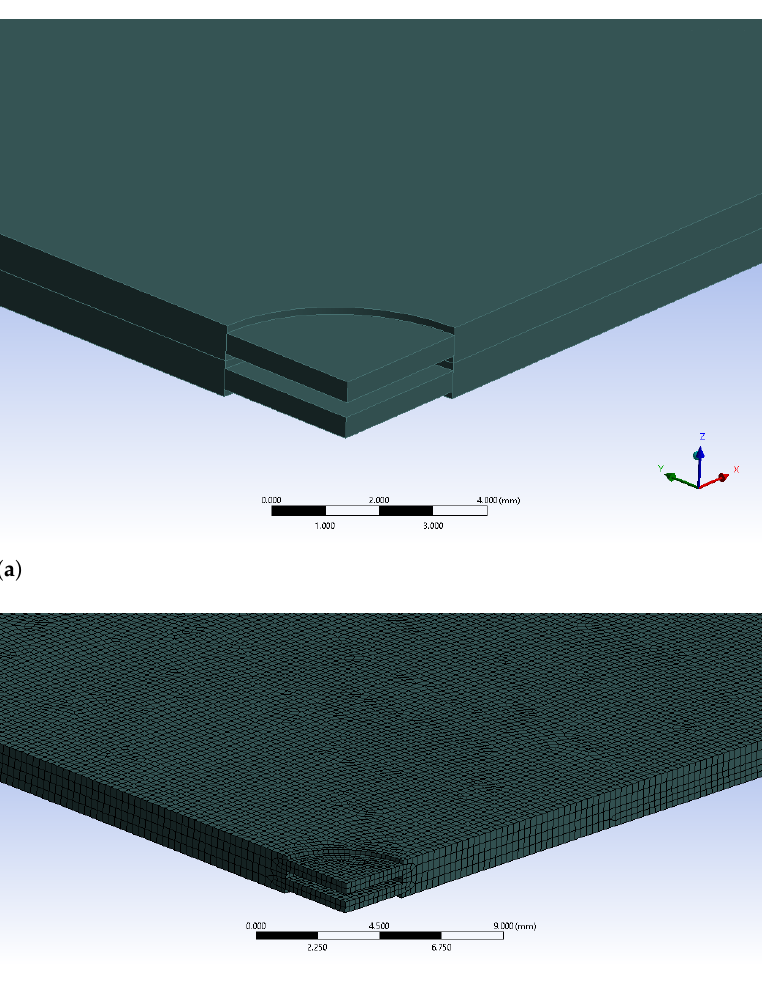
Figure 7. Geometrical model of two wafers with the reduced-thickness configuration. ( a ) Wafers with reduced thickness zone at center; ( b ) FE mesh for reduced thickness silicon wafers.